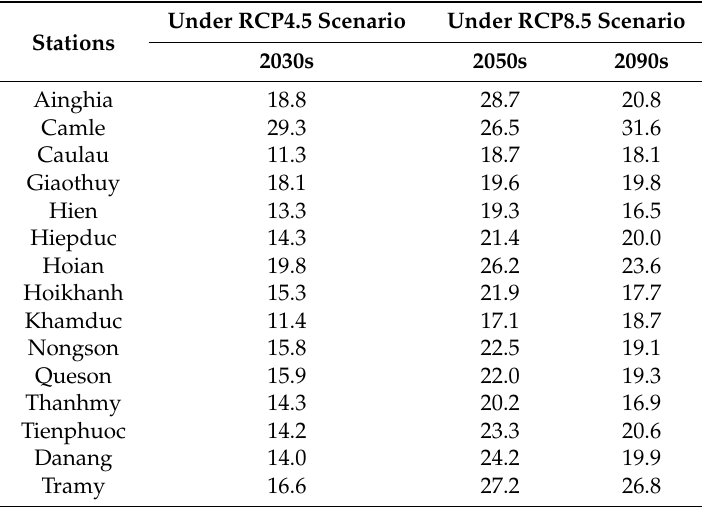
Table 3. Projected precipitation changes under RCP4.5 and RCP8.5 scenarios in comparison with baseline period for 15 stations over the VG-TB basin